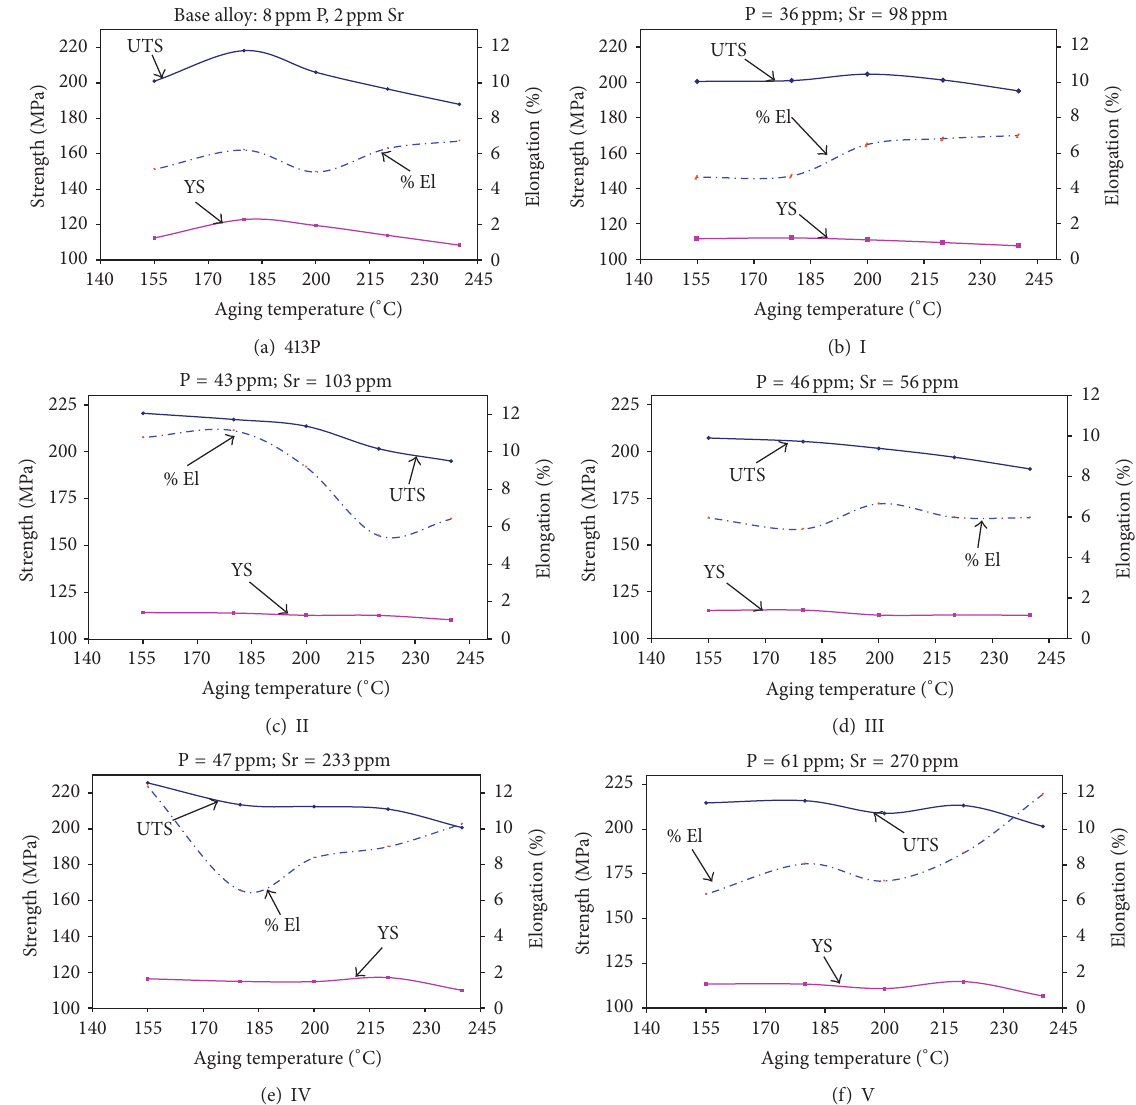
Figure 7: Variation in the tensile properties as a function of aging temperature for (a) base 413P alloy, (b) alloy I, (c) alloy II, (d) alloy III, (e) alloy IV, and (f) alloy